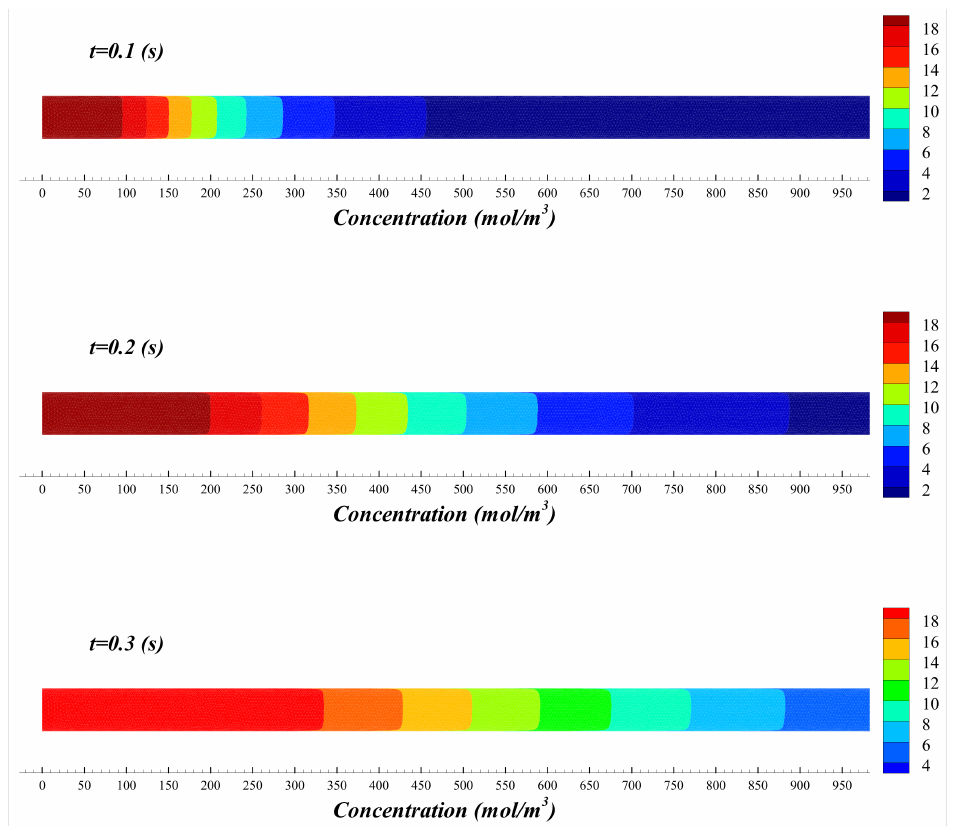
Figure 13. The contours of concentration in the porous collector at the three different times for a high porosity of